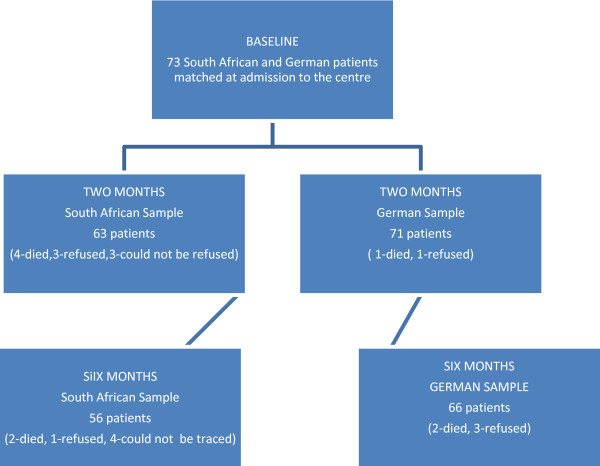
Illustrates the recruitment and lost-to-follow-up of the participants at the different assessment points.